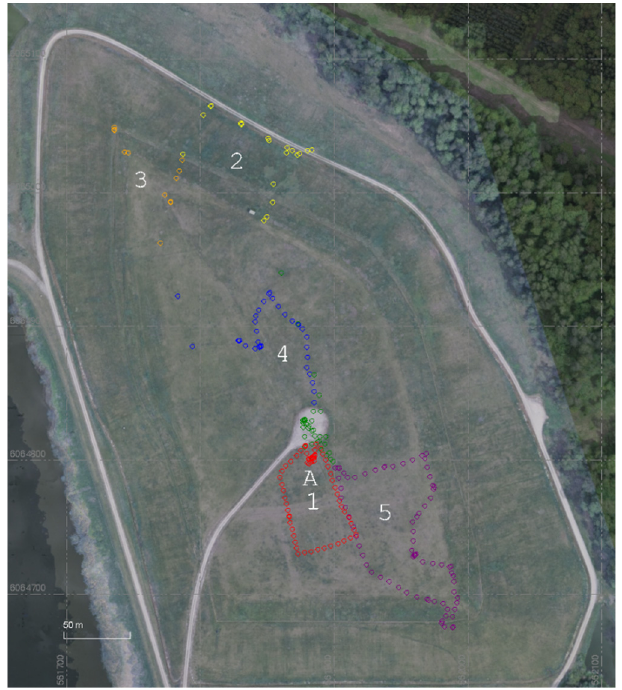
Figure 10. Graphical representation of points of interest and test session.